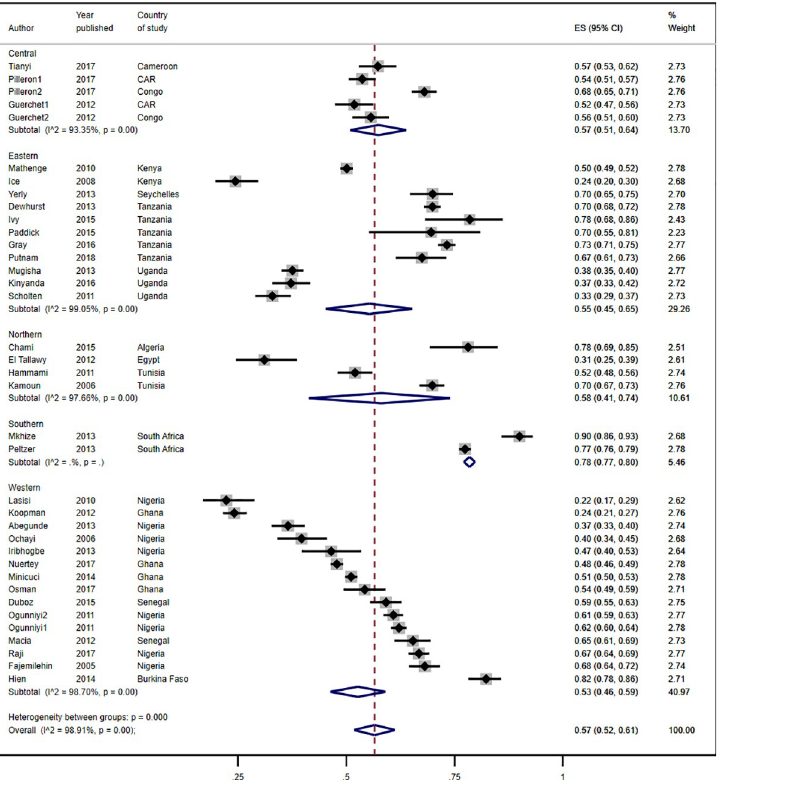
Fig 2. Prevalence estimates of hypertension by African